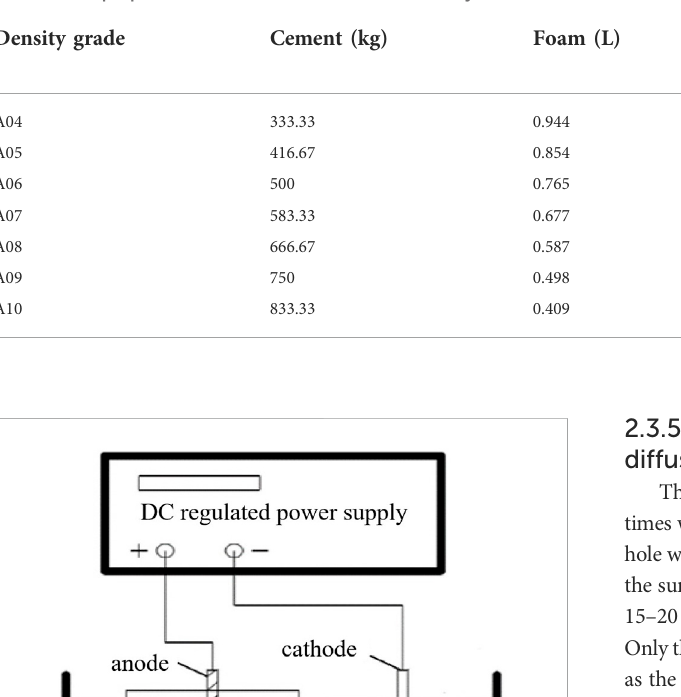
TABLE 2 Mix proportions of foamed concrete with density as variable.